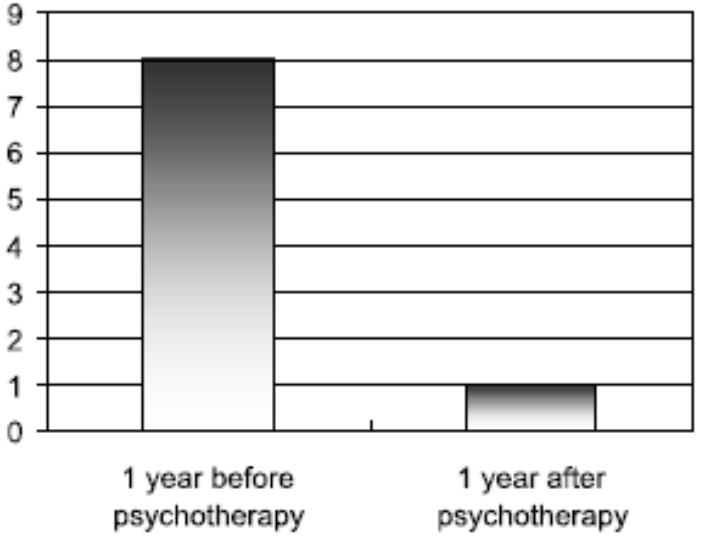
Figure 3. Mean number of days of hospitalization (Figure taken from Keller et al. 1997 with kind permission from the